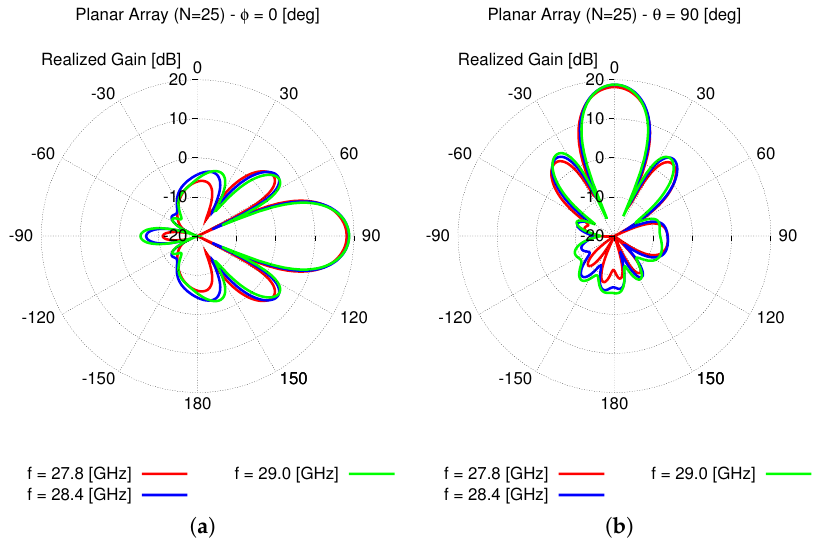
(cid:105) (cid:104) ( p ) ( p ) = [ 27.8, 29.0 ] (GHz))—Polar plot of the realized f , f max min